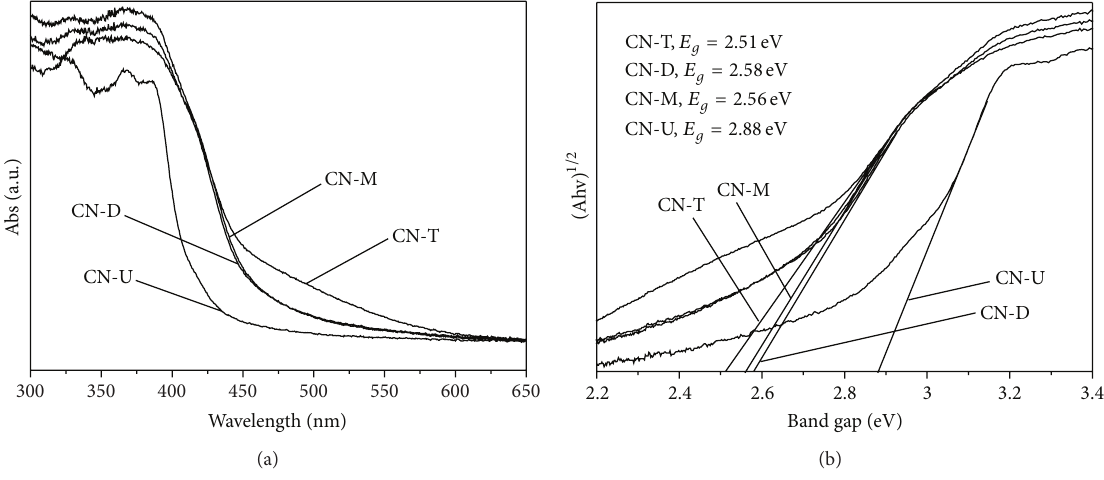
Figure 4: UV-vis DRS (a) and plots of (𝐴ℎ ] ) 1/2 versus photo energy (b) of CN-T, CN-D, CN-M, and CN-U.